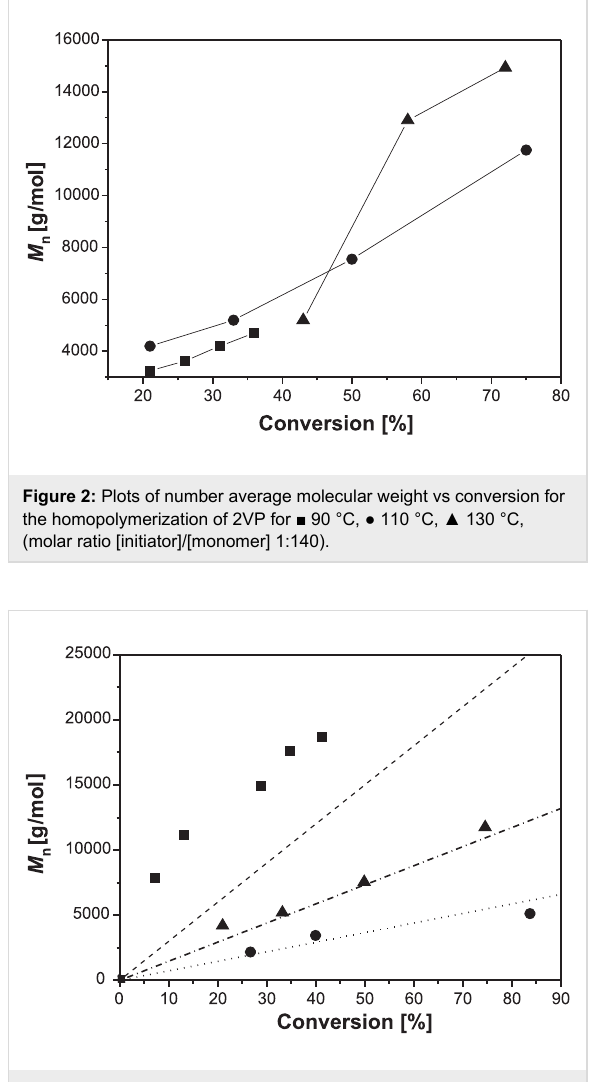
Figure 3: Plot of number average molecular weight vs conversion for the homopolymerization of 2VP at 110 °C with different molar ratios of [initiator]/[monomer] ■ 1:210, ▲ 1:140, ● 1:70. The dashed lines describe the theoretical behavior.